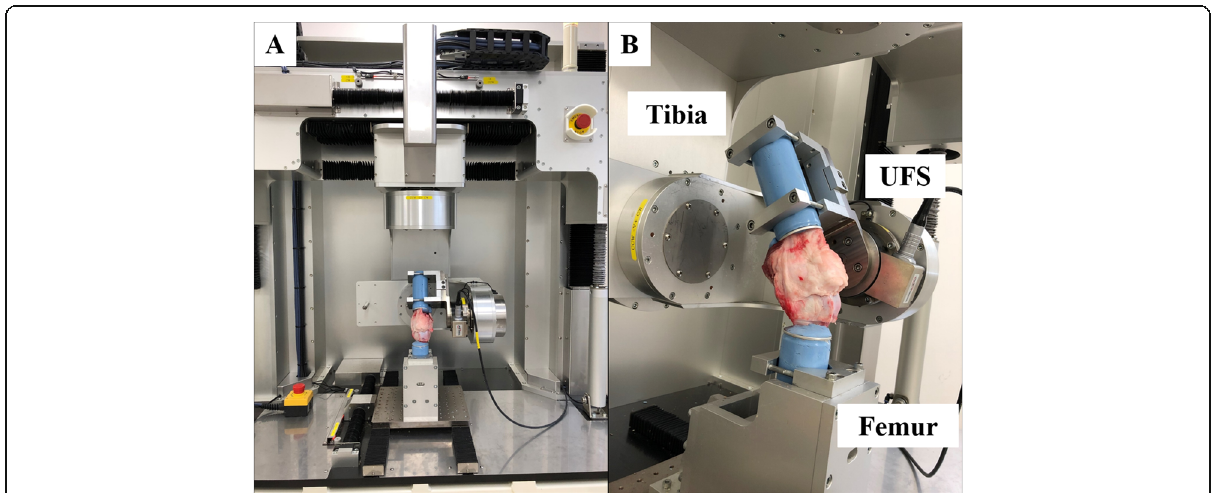
Fig. 1 Six-degree of freedom robotic system. a A whole image of the robotic system. b A knee settled to the simulator via a 6-DOF universal force sensor (UFS)